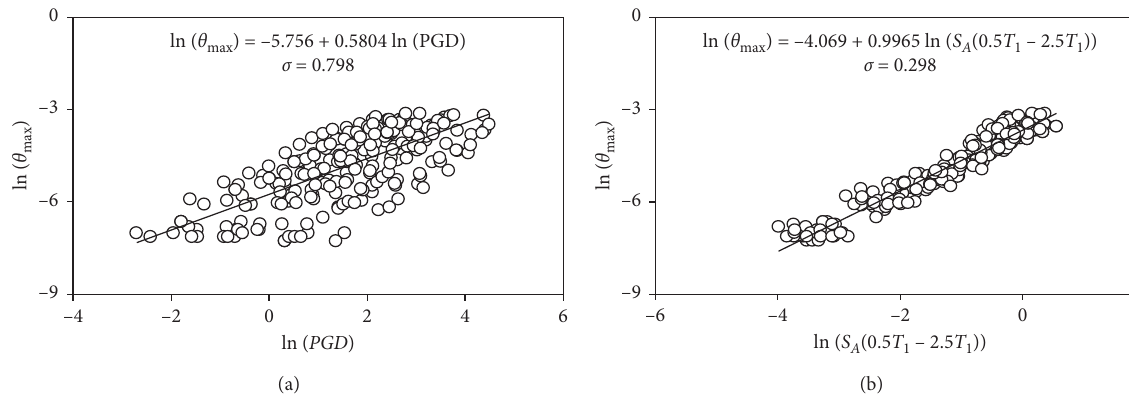
Figure 6: Comparison of the efficiency of two IMs for the asymmetric model with β �− 1.0: (a) PGD; (b) S